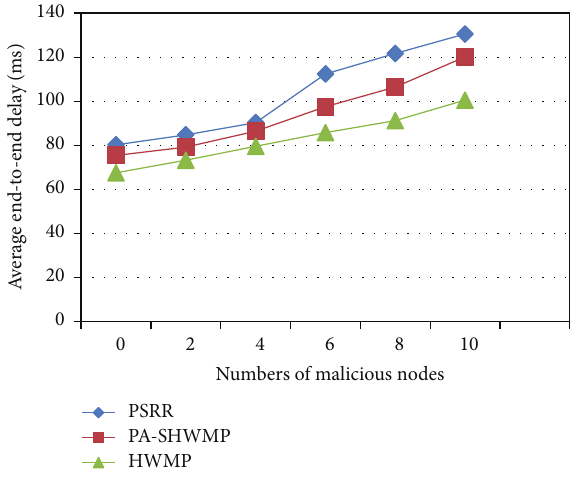
Figure 6: False Positive Rate versus percentage of lossy